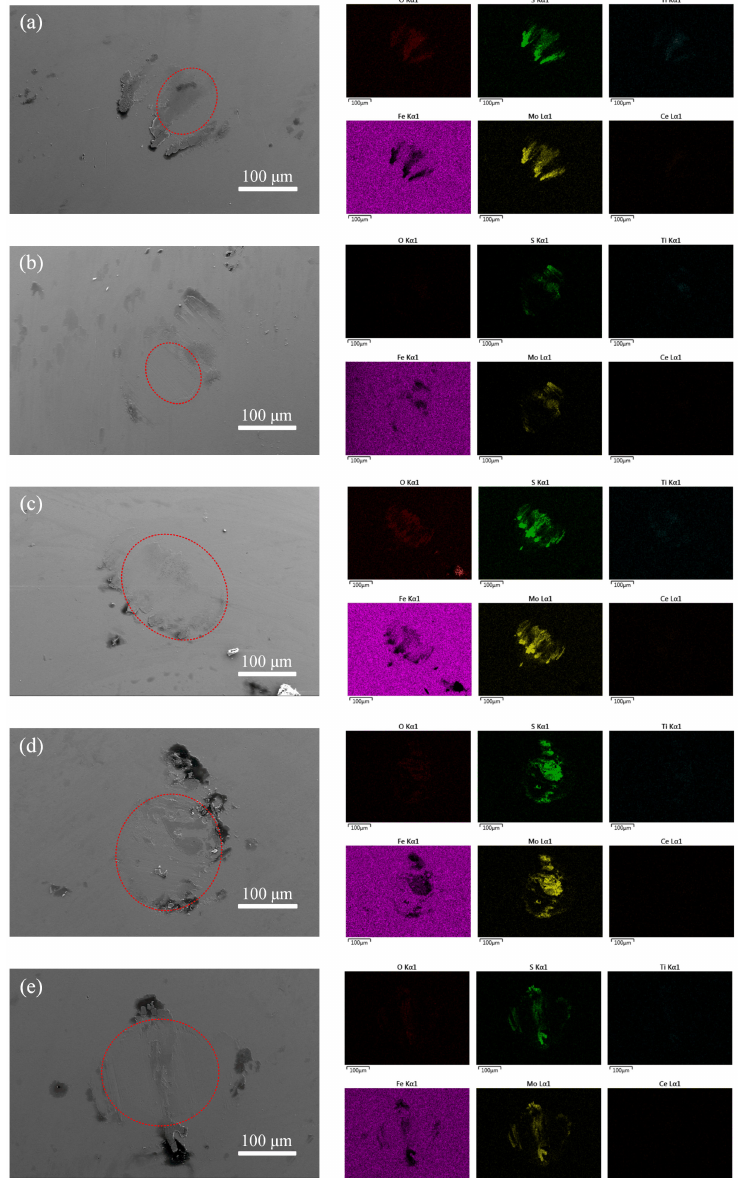
Figure 10. FESEM micrographs and EDS mapping images of the wear scars for ( a ) 0.6 Pa, ( b ) 0.9 Pa, ( c ) 1.2 Pa, ( d ) 1.5 Pa, ( e ) 1.8 Pa. The scratches on the surface of the steel ball are marked with red circles. The scratch area increases with the increase of deposition